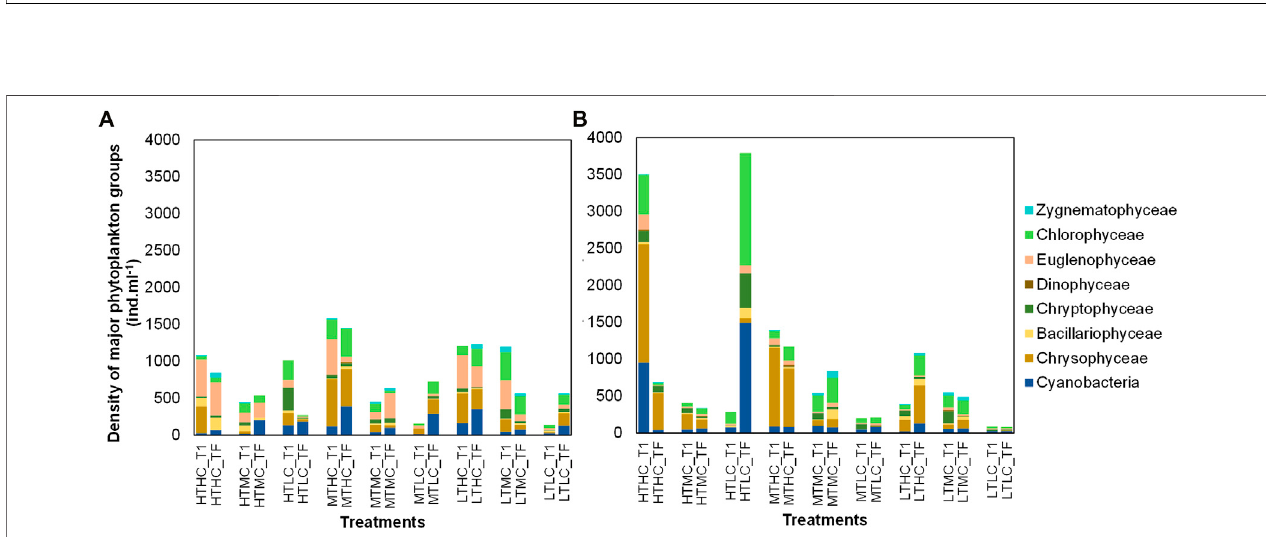
FIGURE4| Differences inalgalyieldamongtreatments ofthesediments. (A) ,NBresults; (B) ,IBresults. NBmeansNatural Batata and IBmeansImpactedBatata. HT:HighTurbidity; MT:MediumTurbidity;LT:LowTurbidity;HC:HighChlorophyll;MC:Medium Chlorophyll;LC:LowChlorophyll.Thegraydottedlineshowsthemean yield value for NB (0.41) and for IB (0.49) treatments.